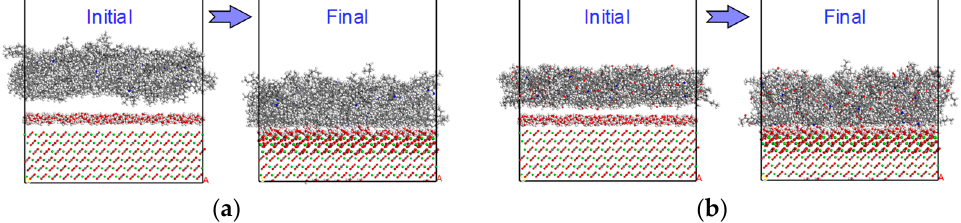
Figure 10. Initial and final model states considered for the wet condition with 3Å water layer at the interface. ( a ) Virgin; ( b ) aged (top vacuum slab not shown in its full thickness).